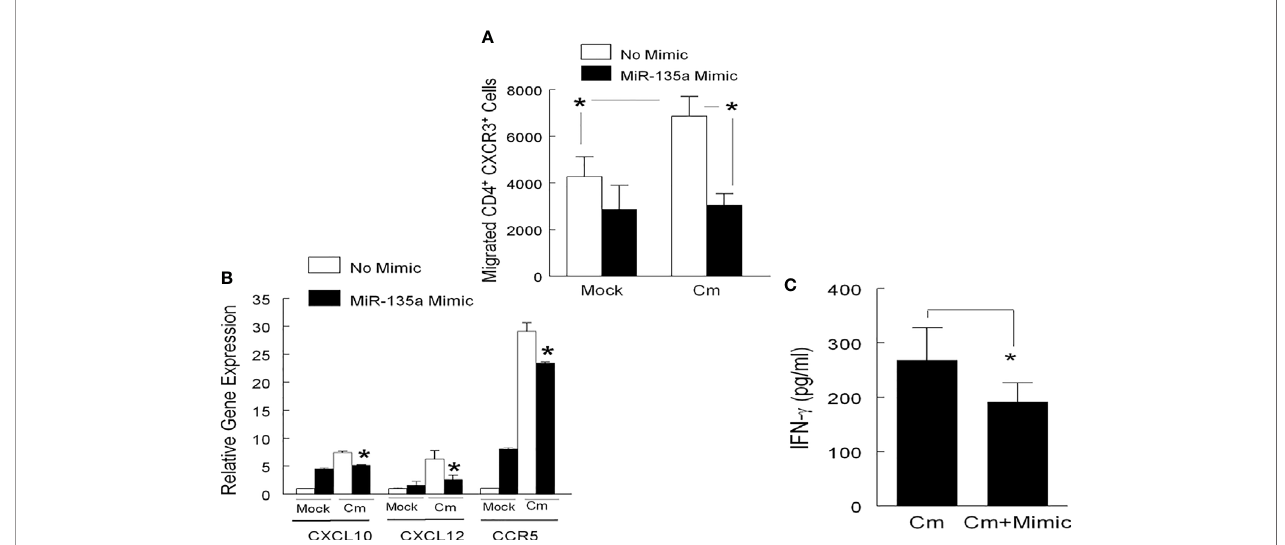
FIGURE 3 | miR-135a affects CD4 + T cell migration. T cell migration was determined using a modi fi ed 24-well Boyden Chamber. Genital tract tissue cell suspensions from mock or Cm infected (day 6) mice were added to the lower chamber (5 x 10 5 per well), and transfected with miR-135a mimic or media alone for 24 hours prior to determination of migration. Enriched CD4 + T cells (from day 6 Cm infected splenocytes) were added to the upper chamber (5 x 10 5 cell per well). Fourteen hours post addition of cells to the upper chamber, the lower chamber contents were used for (A) enumeration of migrated CXCR3-expressing CD4 + T cells by Flow cytometry, (B) comparison of relative CXCL10, CXCL12, and CCR5 gene expression in Cm infected cells transfected with and without miR-135a mimic to the uninfected/non-transfected control group (expression level normalized to 1), and (C) determination of IFN- g secretion. Data shown are representative of 3 experiments. *p < 0.05 Student t